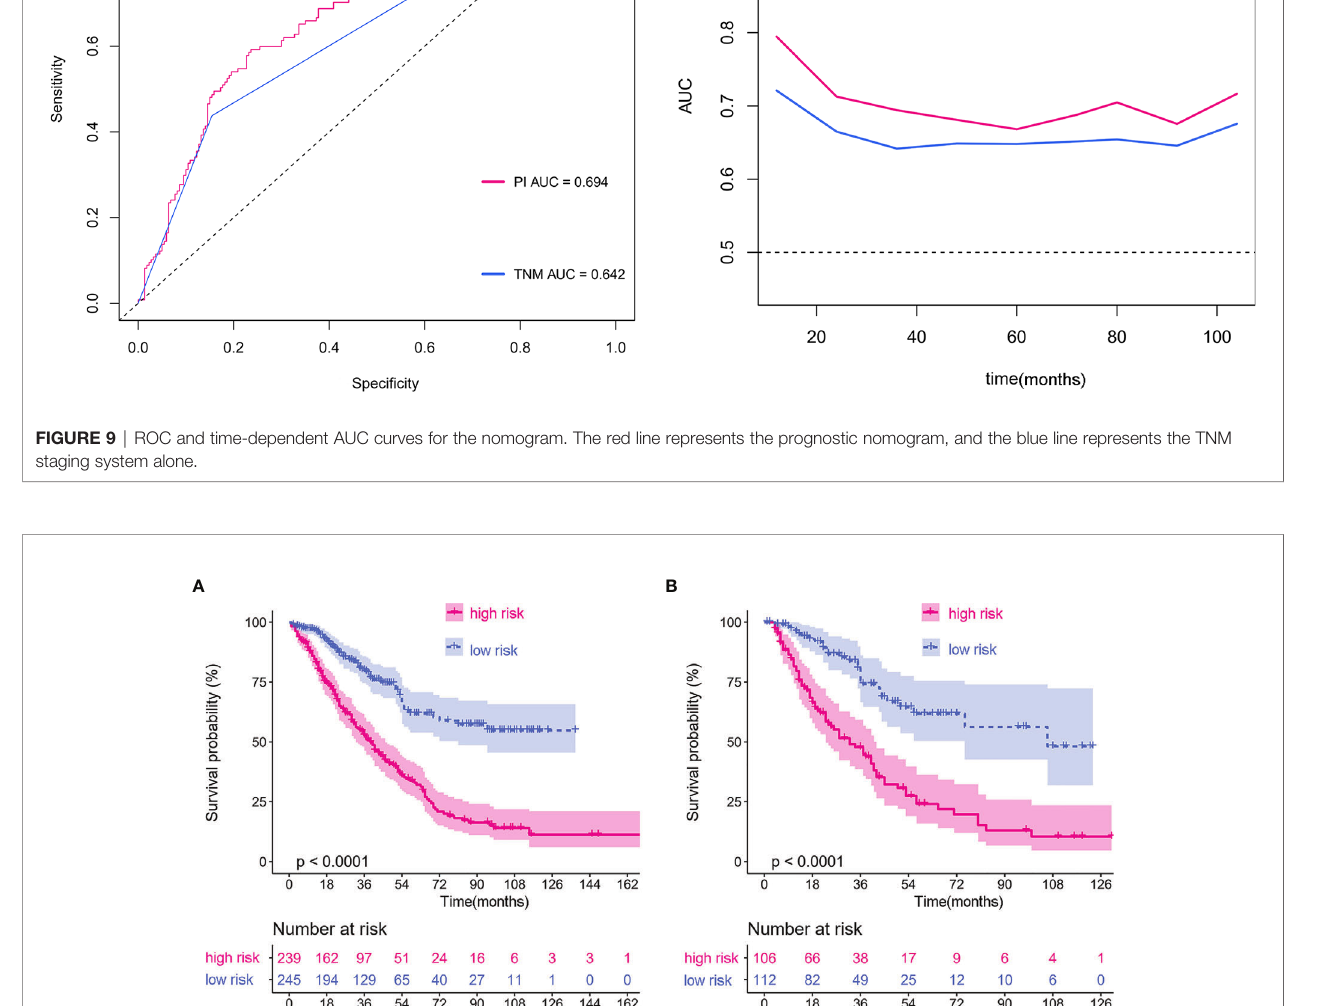
FIGURE 10 | Kaplan – Meier curves of lymph node positive patients based on CRP/MCV strati fi cation. (A) The Kaplan – Meier curve of lymph node positive patients in the training dataset. (B) The Kaplan – Meier curve of lymph node positive patients in the validation dataset. The abscissa represents time in